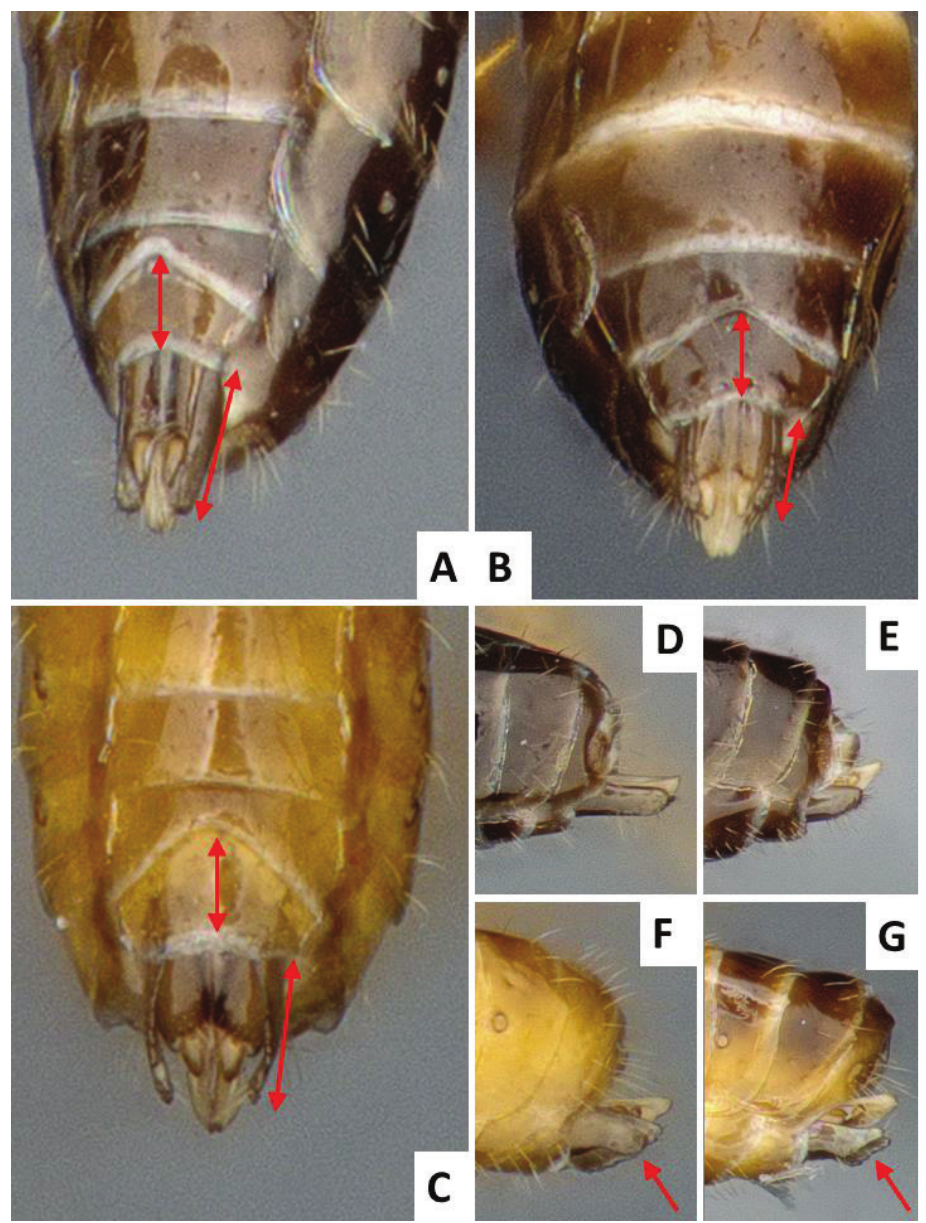
Figure 4. External male genitalia in ventral and lateral view; arrows show length of paramere and sternite 8. A, D Cotesia flavipes specimen from Kenya B, E Cotesia sesamiae , specimen from Kenya C, F, G Cotesia typhae , paratype specimen from